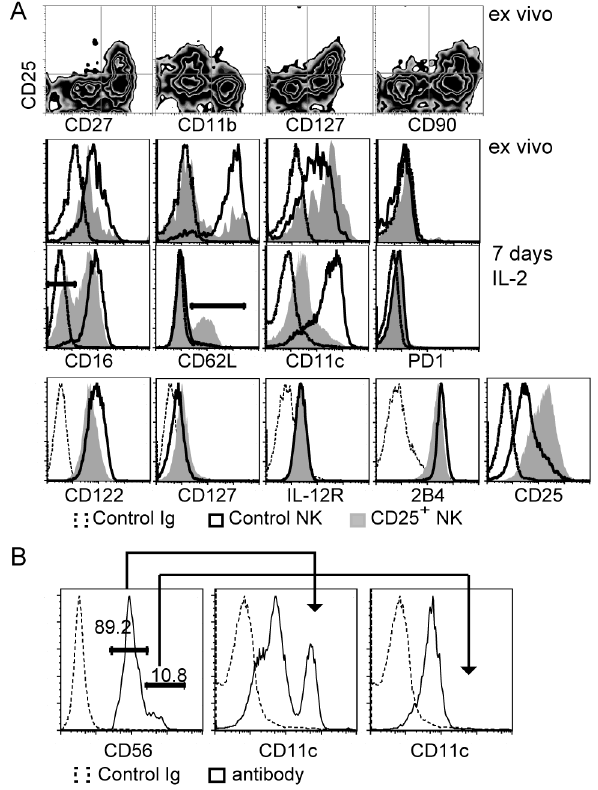
Figure 3. Post-activation and non-activated murine NK cells differ phenotypically. A. Ex vivo analyses of B16-bearing mice revealed that NK cell activation was restricted to a subset that expressed CD27, CD90, CD127 and was low for CD11b (top row). The same cells revealed differences in the expression of CD16, CD62L and CD11c when CD25 + were compared with CD25 2 NK cells (2 nd row). Post-activation CD25 + NK cells isolated from spleens of B16-bearing mice and control NK cells isolated from normal spleens were also differentiated for 7 days in IL-2 in vitro. Cytometry analyses revealed differences in the surface expression of CD16, CD62L, CD11c and CD25 between both cell types after IL-2 differentiation (3 rd row). Little differences were observed for CD122, CD127, IL-12R b 2 and 2B4 (bottom row). Similar phenotypical differences were seen when CD25 + and CD25 2 NK cells were compared that had been isolated from the same B16-bearing mice and differentiated in IL-2 (not shown). B. Analyses of sorted human NK cells showed that a population with high expression of CD11c is found among CD3 2 /CD56 dim but not within the CD3 2 / CD56 br ight subset of NK cells. All phenotypical differences were reproducible in at least three independent experiments.